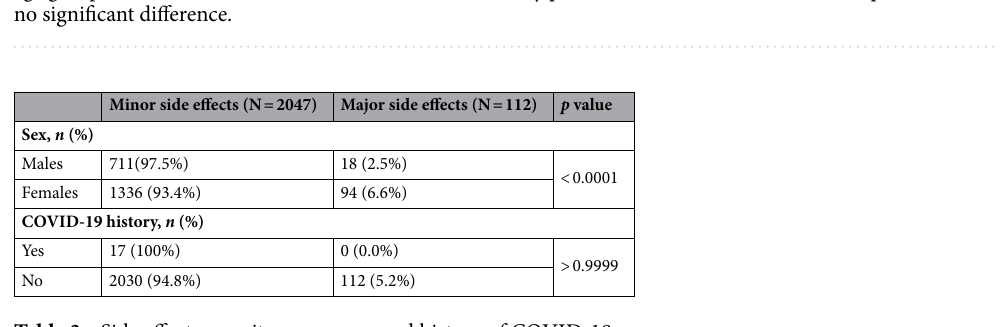
Table 3. Side effects severity among sex and history of